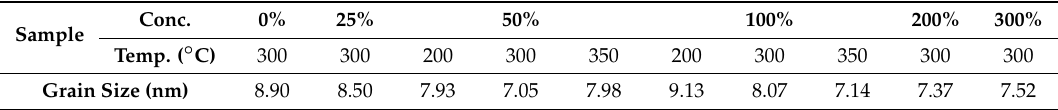
Table 1. Calculated grain sizes of various photocatalytic C–TiO 2 thin films. (Calcining temperatures for all unmarked samples are 300 °C.)